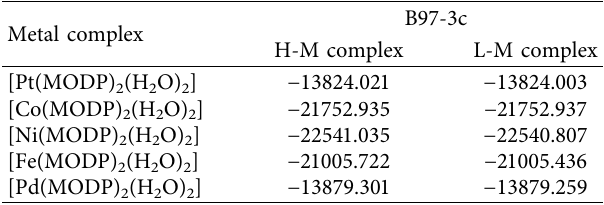
Table 1: Energy (in kcal/mol) of the studied complexes at the different spin states computed using the B97-3c method in gas